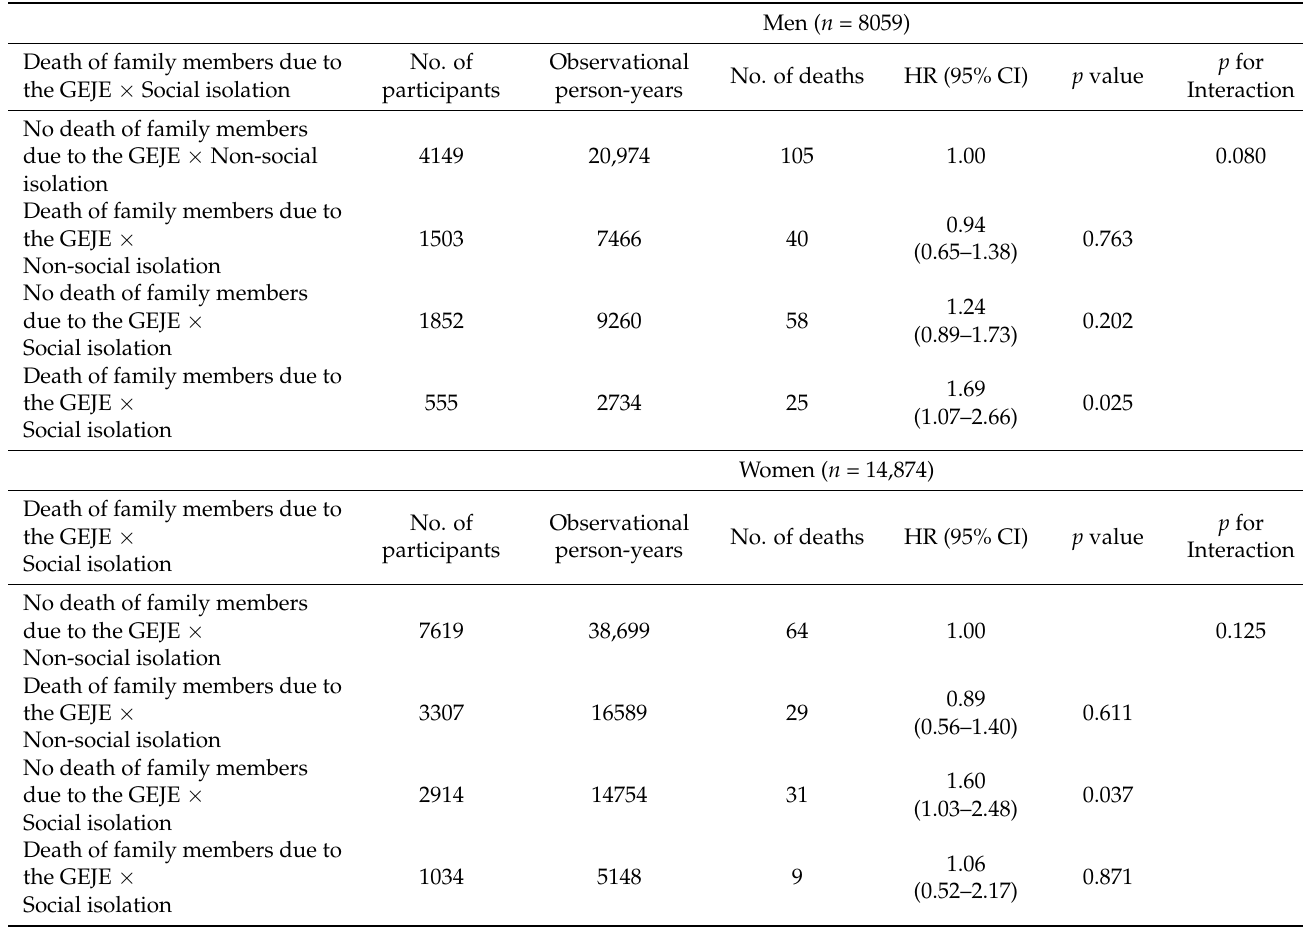
Table 5. Adjusted HRs (95% CI) of mortality according to the death of family members due to the GEJE and social